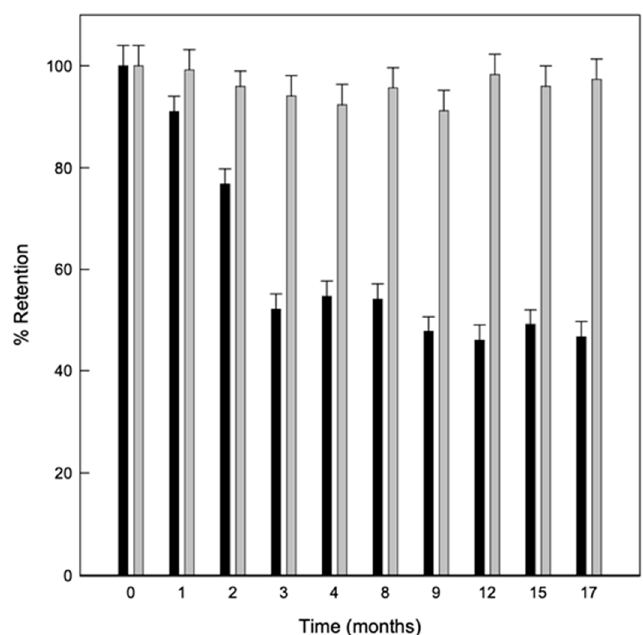
Figure 5. Evolution of linalool retained in solid complexes stored for 17 months at 8 °C (grey bars) and 25 °C (black bars) Values represent means of triplicate determination.